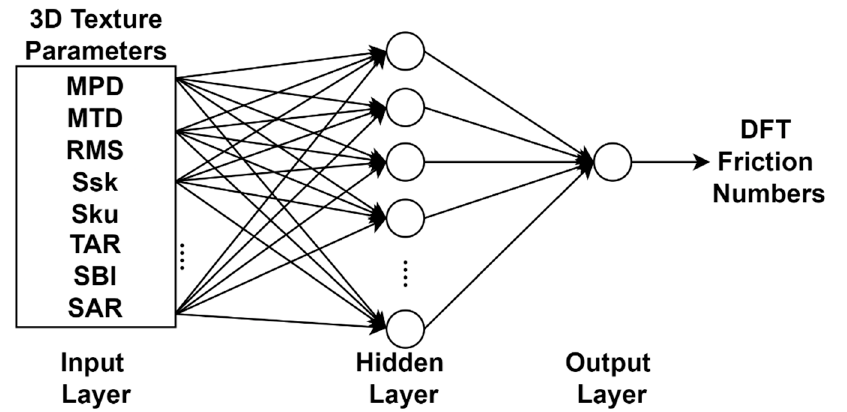
Figure 7. Example structure of ANN model.